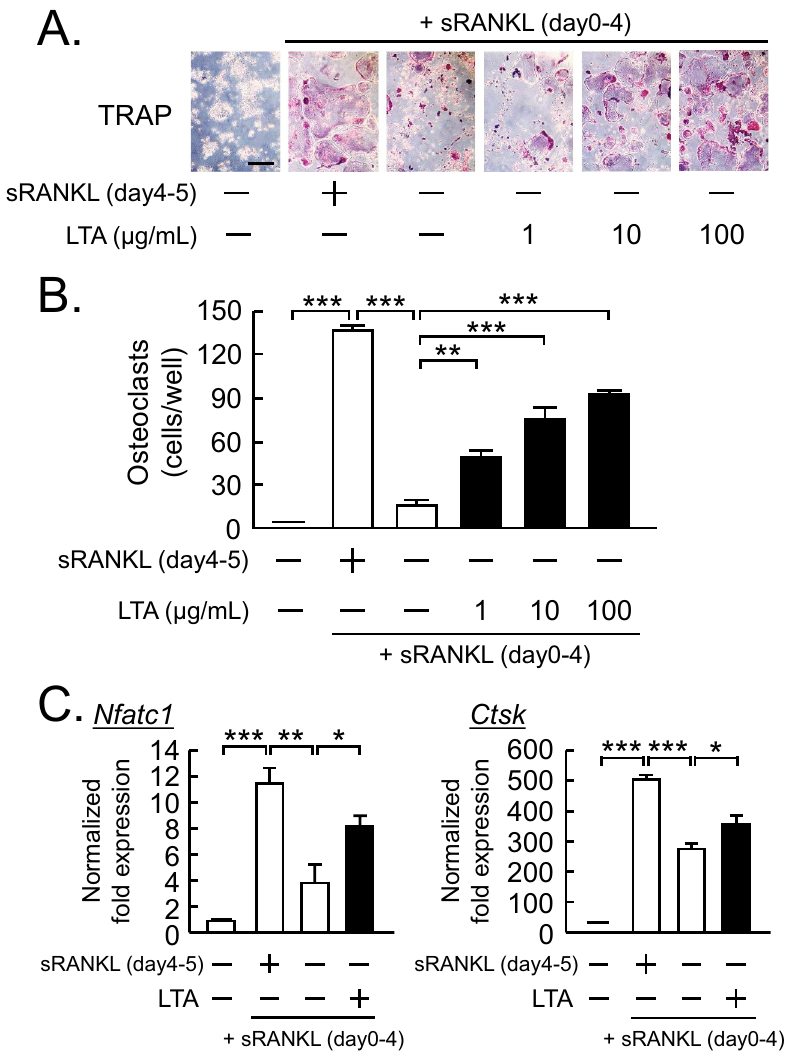
Figure 4. LTA enhanced the lifespan of mature osteoclasts. ( A ) Raw264.7 cells were cultured with sRANKL (100 ng/mL) for 4 days. After the formation of mature osteoclasts, osteoclasts were treated with LTA (1, 10, 100 μg/mL) in the absence of sRANKL for 1 day. The images showed TRAP-positive multinuclear osteoclasts. Scale bar: 200 μm. ( B ) TRAP-positive multinuclear osteoclasts were counted. The data are expressed as the mean ± SEM of 4 wells. ( C ) Osteoclasts were treated with LTA (100 μg/mL) or sRANKL (100 ng/mL). The mRNA expression of Nfatc1 and Ctsk was analyzed by qPCR. The data are expressed as the means ± SEM of triplicate from a representative experiment. β-actin ( Actb ) was used as a normalized gene. A significant difference between the two groups was indicated; * P < 0.05, ** P < 0.01 and *** P < 0.001; by one-way ANOVA and Tukey’s post hoc